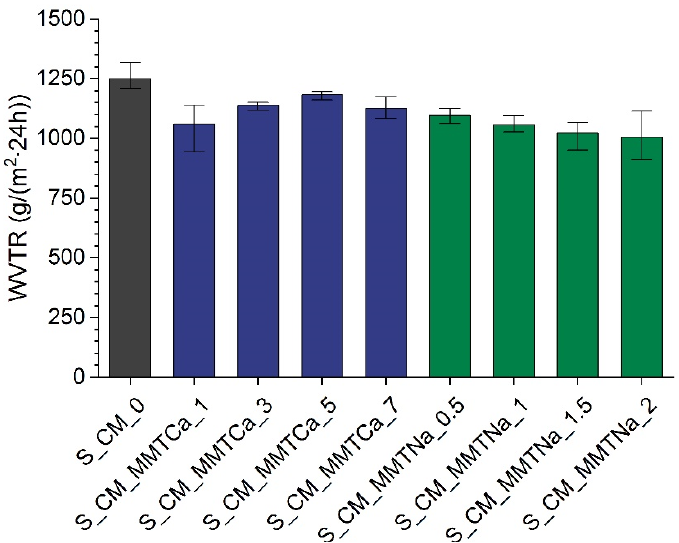
Figure 7. Water vapor transmission rate of starch films with various calcium and sodium montmorillonite contents.